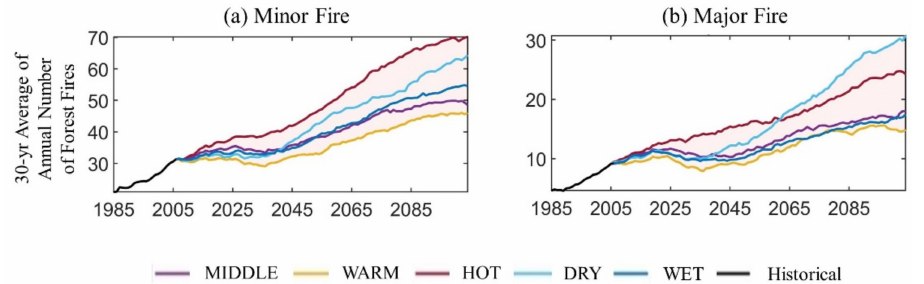
Figure 5. Changes in the rate of ( a ) minor fire, and ( b ) major fire from 1985 to 2099 under the historical and five climate scenarios.